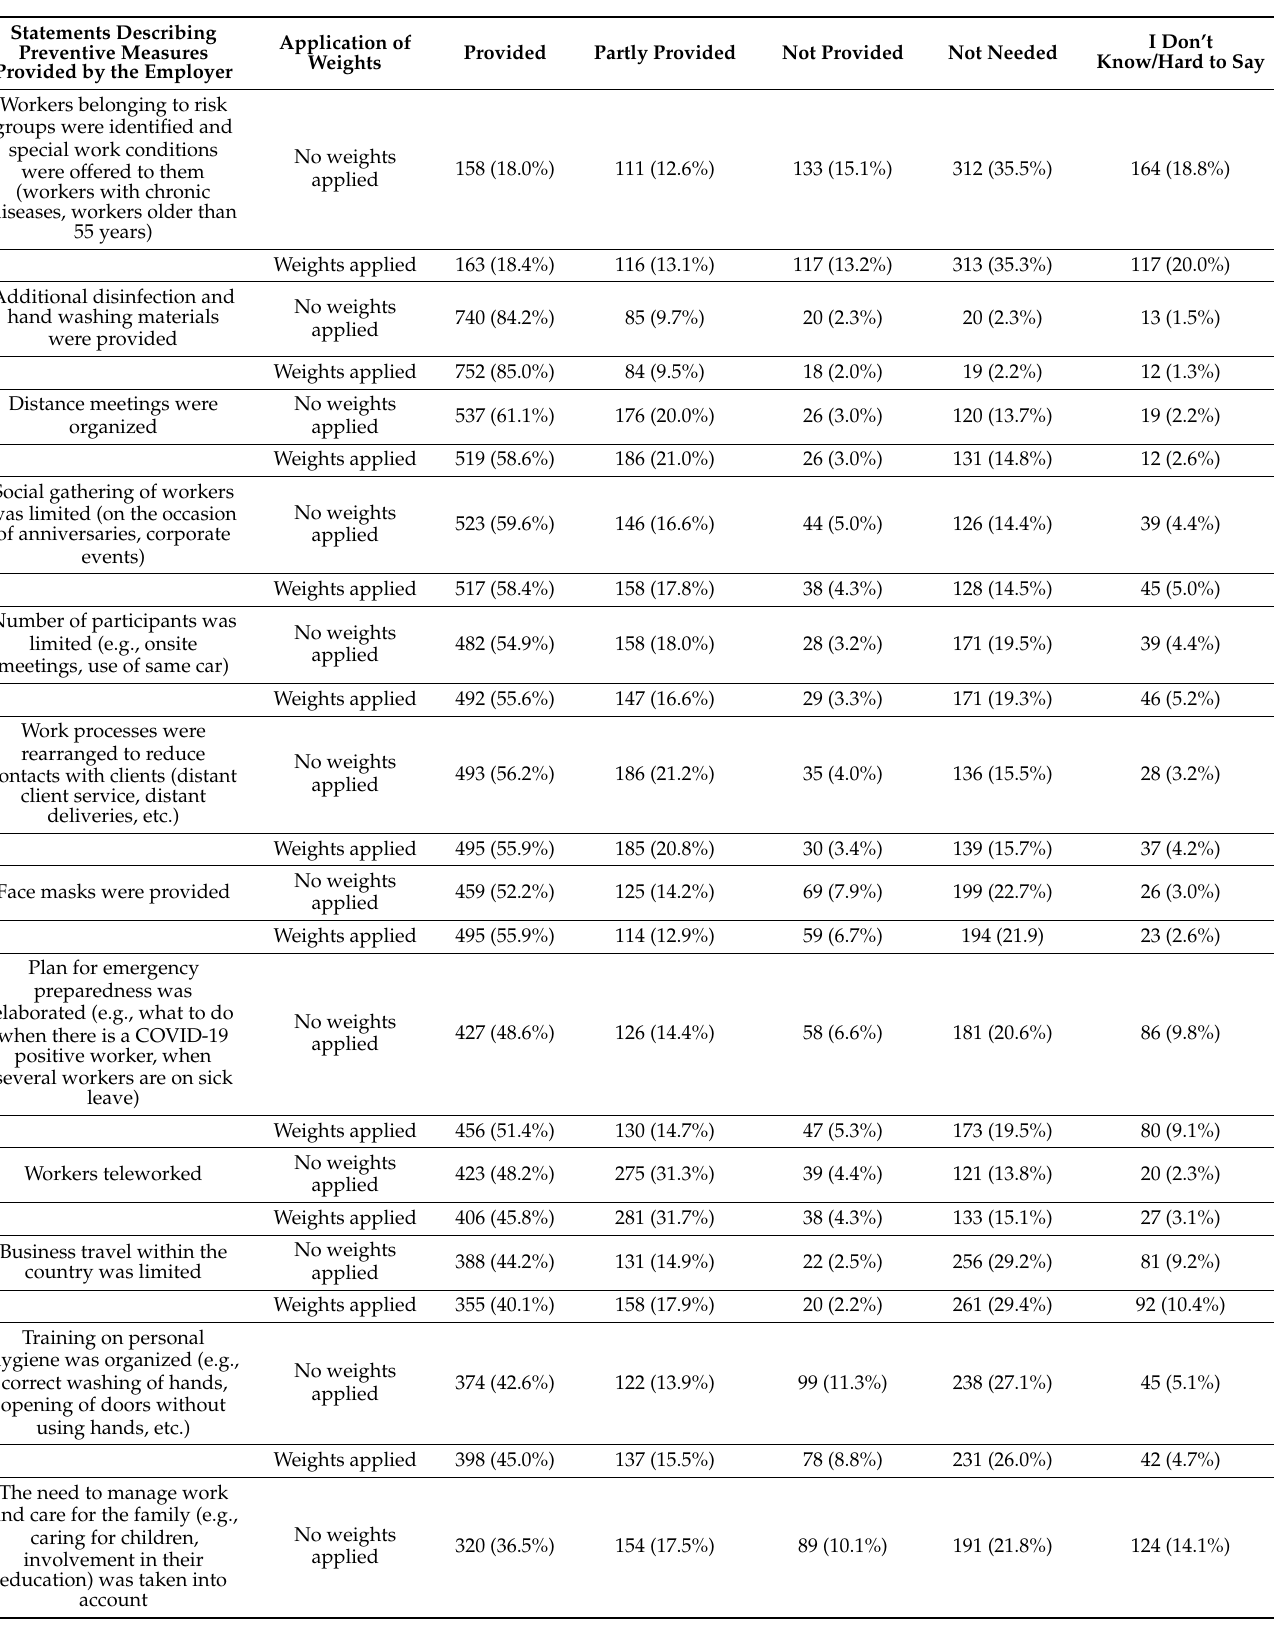
Table A2. Prevalence of respondents reporting implementation level of preventive measures to reduce spreading of COVID-19 virus in workplaces, n